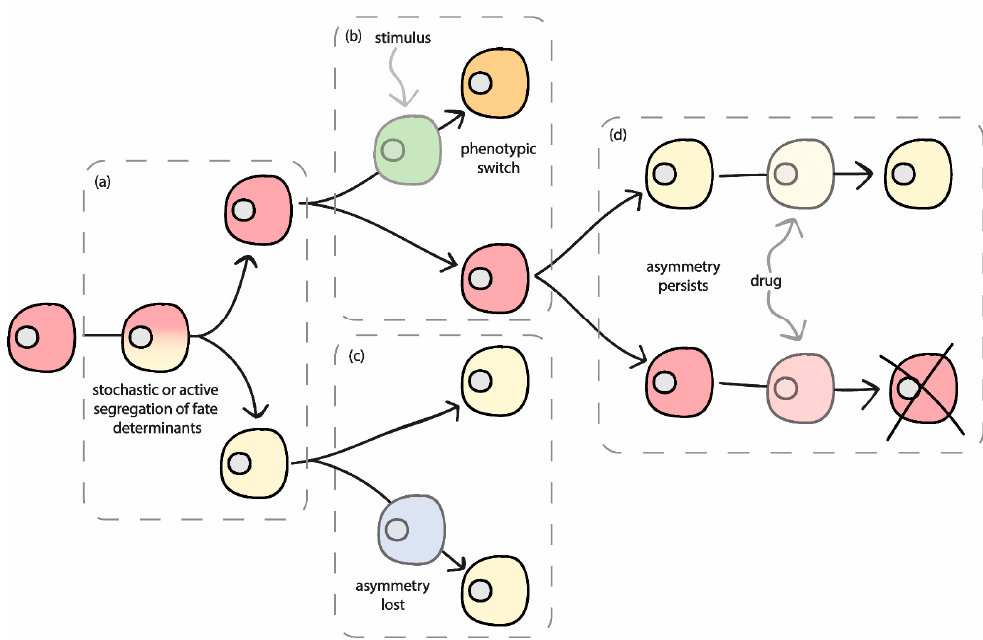
Figure 2. Potential consequences of asymmetric cell division. Phenotypically different cells may arise in a clonal population by passive—diffusion-mediated—or active mechanisms ( a ). Subsequently, this non-genetic heterogeneity may persist in clonal populations and may set the basis for phenotypic switches upon exposure to various external stimuli ( b ). On the other hand, phenotypic differences may be eliminated shortly after cell division, as specific mechanisms might act to diminish cell division-induced asymmetry ( c ). Moreover, phenotypic variation in cell populations may increase fitness and enable survival of some cells under exposure to lethal cues ( d ). Table 1. Fate determinants asymmetrically inherited during cell